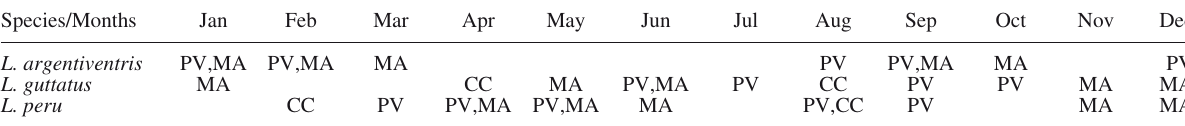
Table 6. – Spawning period of Lutjanus argentiventris , L. guttatus and L. peru for the three geographic areas: PV, Puerto Vallarta; MA, Manzanillo; and CC, Caleta de Campos. Data for PV and MA from Espino-Barr et al. (2010, 2011) and Gallardo-Cabello et al. (2010) and for CC from Sarabia-Méndez et al. (2010).